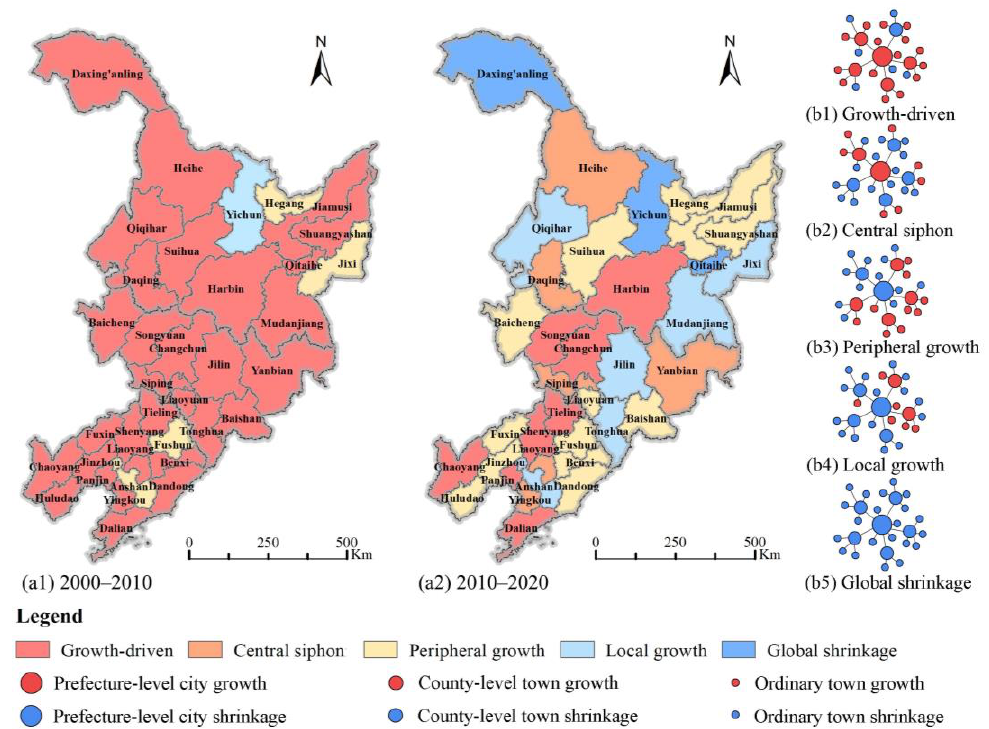
Figure 6. Types of multilevel associations of urban shrinkage in Northeast China. Subfigure ( a1 ) and ( a2 ) show the types of multilevel associations of urban shrinkage in Northeast China during the period 2000 – 2010 and the period 2010 – 2020, respectively; Subfigure ( b1 – b5 ) show the five types of multilevel associations of urban shrinkage, respectively.